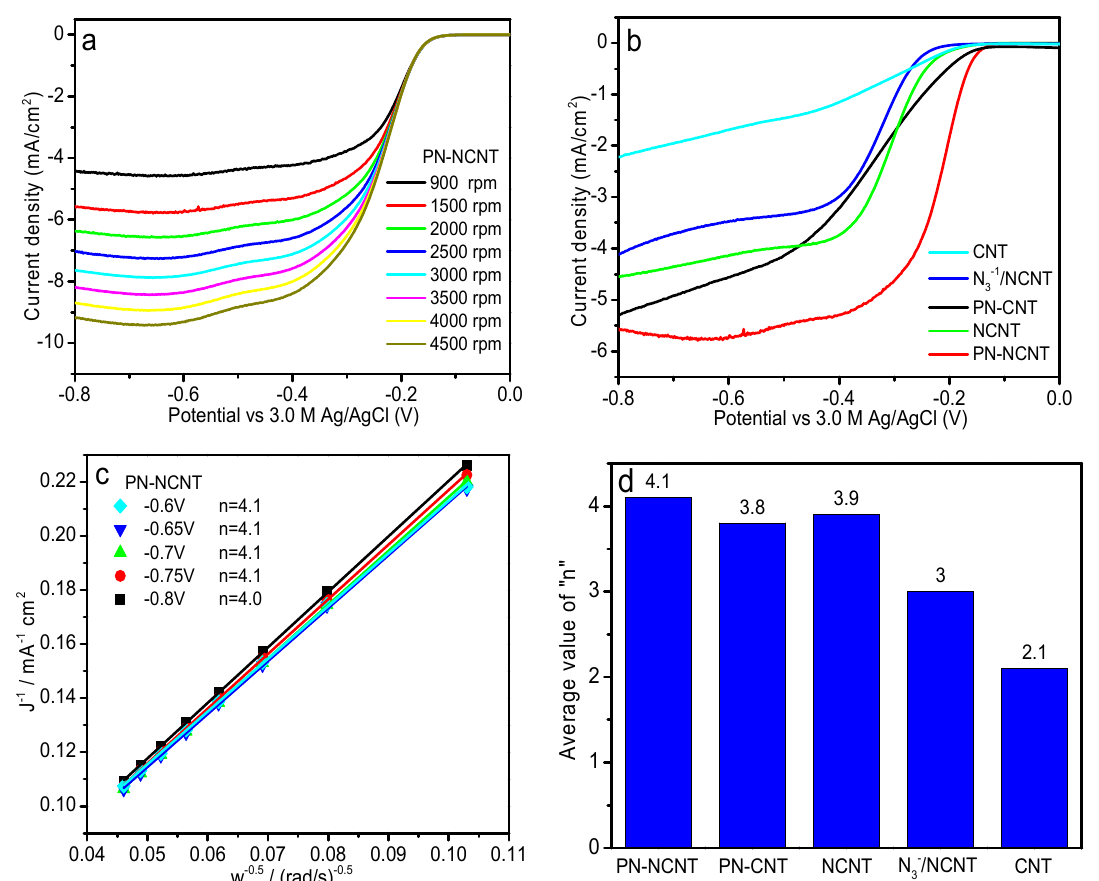
Figure 3. ( a ) LSV curves of PN-NCNT using oxygen-saturated 0.1 M KOH solution as electrolyte at scan rate of 5 mV/s. ( b ) LSV curves of PN-NCNT, PN-CNT, NCNT, N 3− /NCNT, and CNT using oxygen-saturated 0.1 M KOH solution as electrolyte with rotation speed of 1500 rpm at scan rate of 5 mV/s. ( c ) K-L plots of PN-NCNT at different potentials. ( d ) Average electron transfer number n of PN-NCNT, PN-CNT, NCNT, N 3− /NCNT, and CNT calculated from K-L equation.